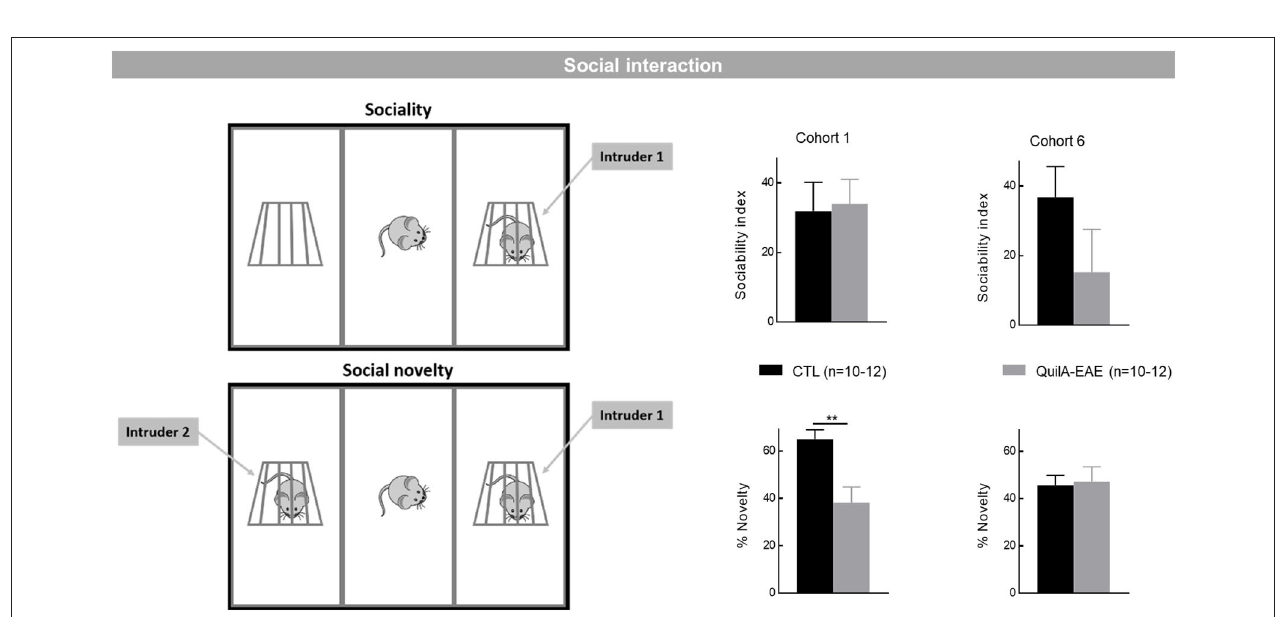
FIGURE 5 | Evaluation of cognitive behaviors using the three-chamber sociability and social novelty test in mice immunized with MOG 35 − 55 (QuilA-EAE) and their controls (CTL) at post-induction Day 30. Left: Schematic representation of the three-chamber sociability and social novelty test. Top: the T1 session when an unfamiliar adult WT female mouse was placed in one of the wire cups for the evaluation of sociability. Bottom: the T2 session where the first intruder is still posted in its wire cup but another unfamiliar adult WT female mouse was placed in the second cup for the evaluation of preference for social novelty. Top right: Sociability evaluated using the sociability index (exploration time of unfamiliar mice – exploration time of empty cup / total exploration time of both cups) ± SEM over the T1 5min session. Bottom right: Social novelty evaluated using the percentage of novelty [(exploration time of unfamiliar mice/total exploration time of both mice) × 100] ± SEM for the T2 5min session. Statistical analysis was performed using Student t -test, ** p < 0.01 vs.